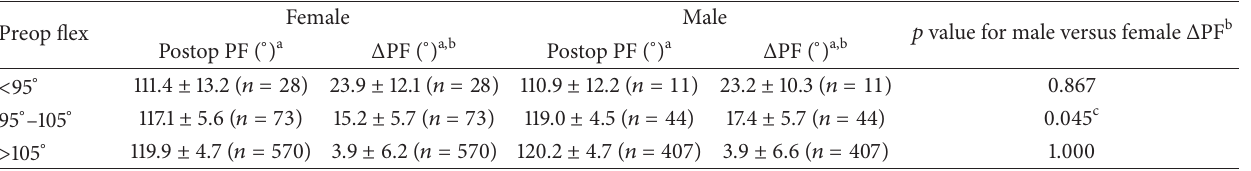
Table 5: Peak flexion (PF) comparisons after a minimum of 2